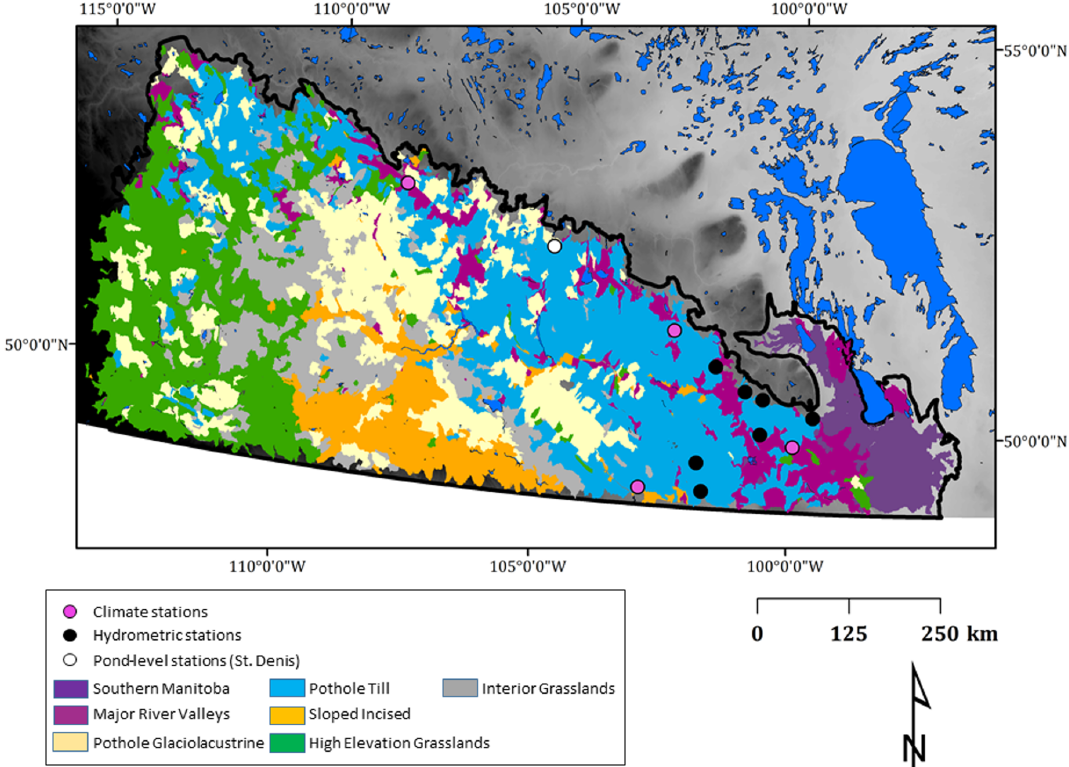
Figure 1. The seven classes of basins in the Canadian Prairie ecozone. The focus of this research is on the Pothole Till class (in light blue).